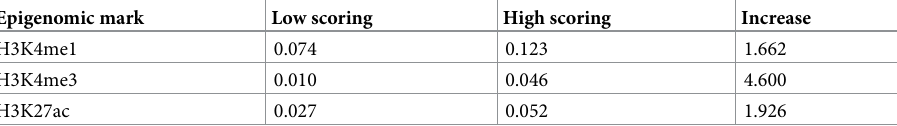
Table 2. Enrichment for epigenomic marks of low scoring and high scoring